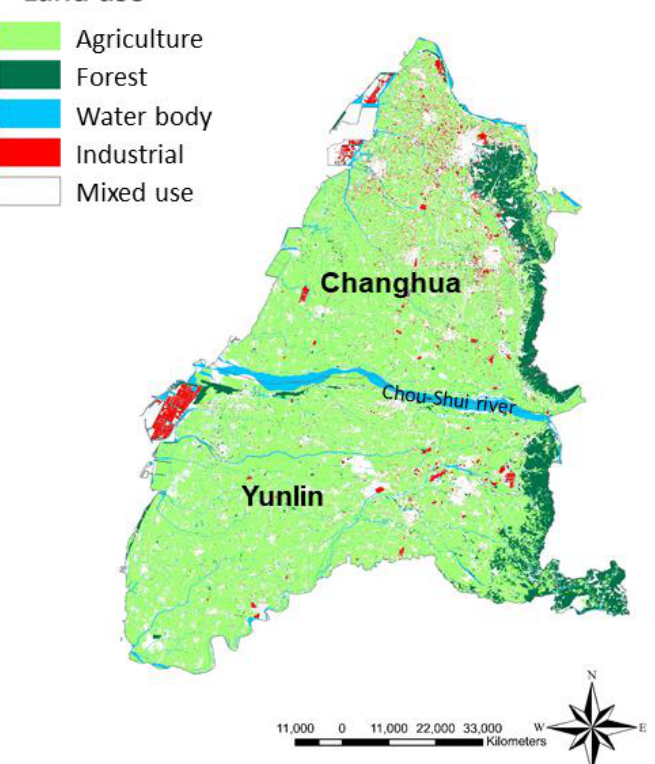
Figure 1. Inventory of land use in Changhua (upper area) and Yunlin (lower area) Counties. Chou-Shui river flows through and therefore forms a border for the two counties.